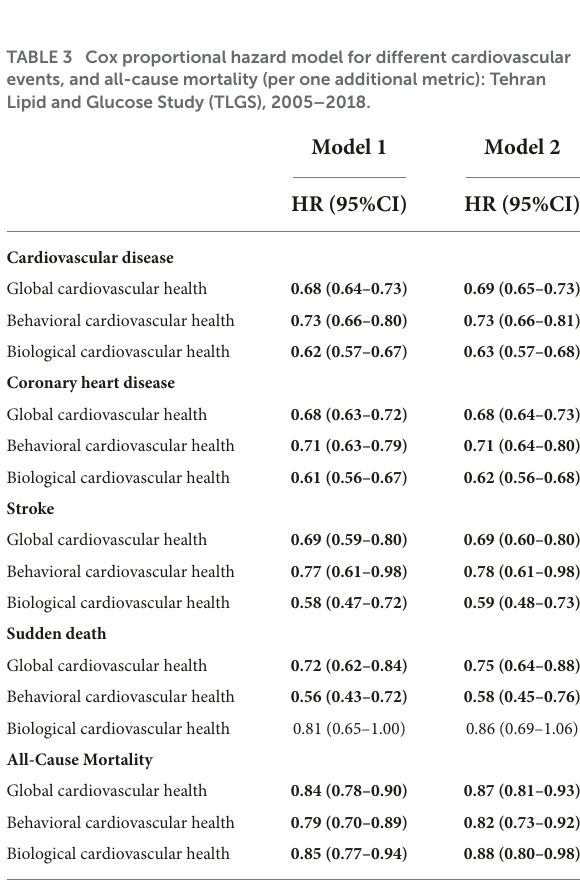
Model 1: Adjusted for sex and age. Model 2: Further adjusted for educational level, maritalstatus,familyhistoryofCVD,andprevalentCVD(forall-causemortality).CVD,